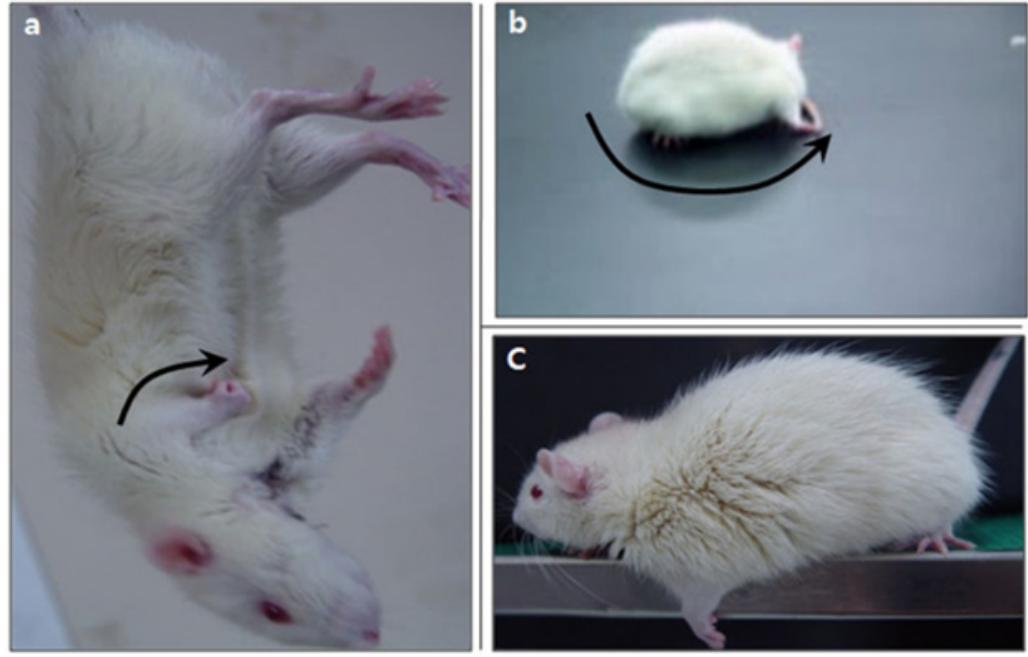
Figure 3. Neurological dysfunction in WKY and SHR rats with sham or MCAo surgery. ( a ) Paralytic forelimb was flexed during tail suspension (arrow). ( b ) Spontaneous circling was shown on the paretic side. ( c ) Decreased grip power of the left forelimb when the tail was